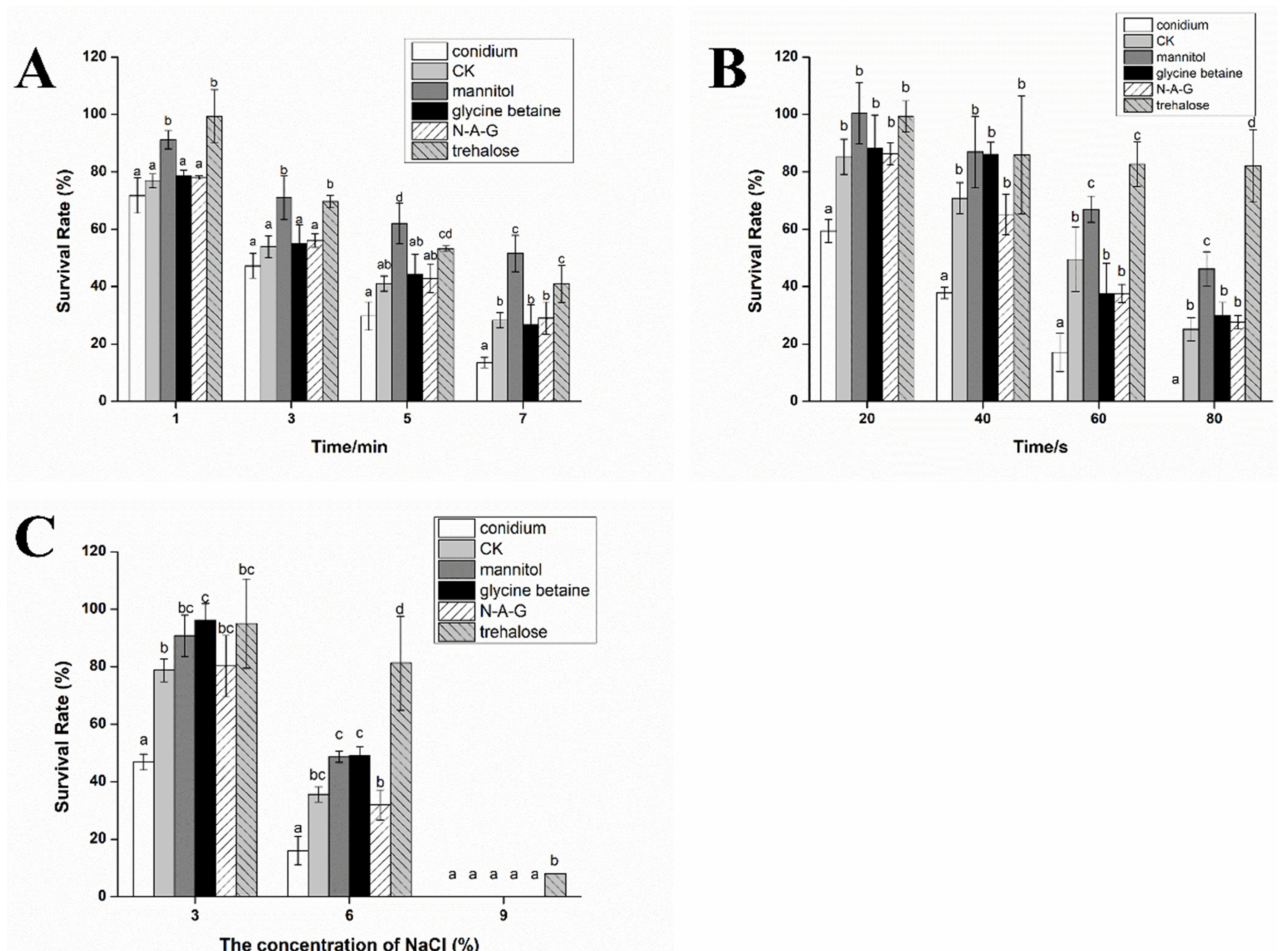
Figure 2. Stress resistance ability of chlamydospores produced by adding different exogenous regula- tors: ( A ) heat stress, ( B ) UV stress, and ( C ) hypertonic stress. The data are from three independent repeated experiments. The different letters above the bars indicate that the survival rates of chlamy- dospores produced by adding different exogenous regulators are significantly different when facing different environmental pressures, according to the least significant difference test ( p <